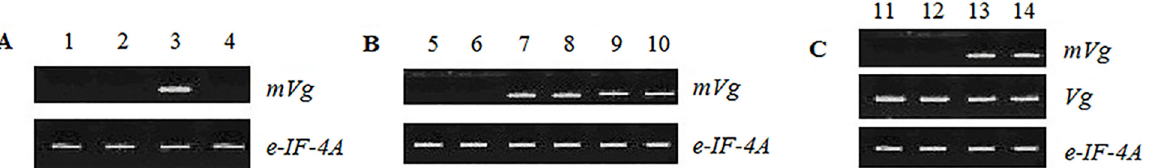
Fig 3. Expression of the mVg gene. (A) The developmental stages 1 – 4 represent eggs, larvae, pupae, and adults, respectively. (B) Tissue distributions in the pupal stage. The labels 5 – 10 indicate the brain, hemolymph ( ♀ ), fat body ( ♀ ), ovaries ( ♀ ), spermaries ( ♂ ), and fat body ( ♂ ), respectively. (C)